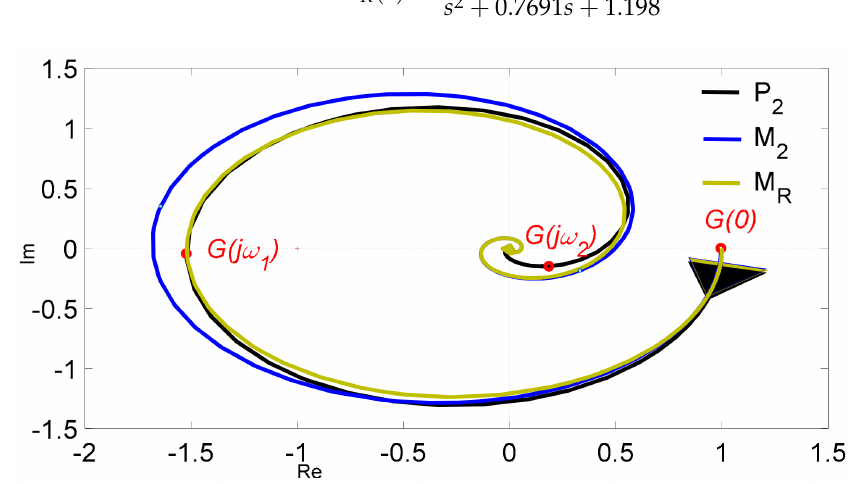
Figure 10. The Nyquist frequency plots of transfer functions P 2 ( s ), M 2 ( s ), and M R ( s ).